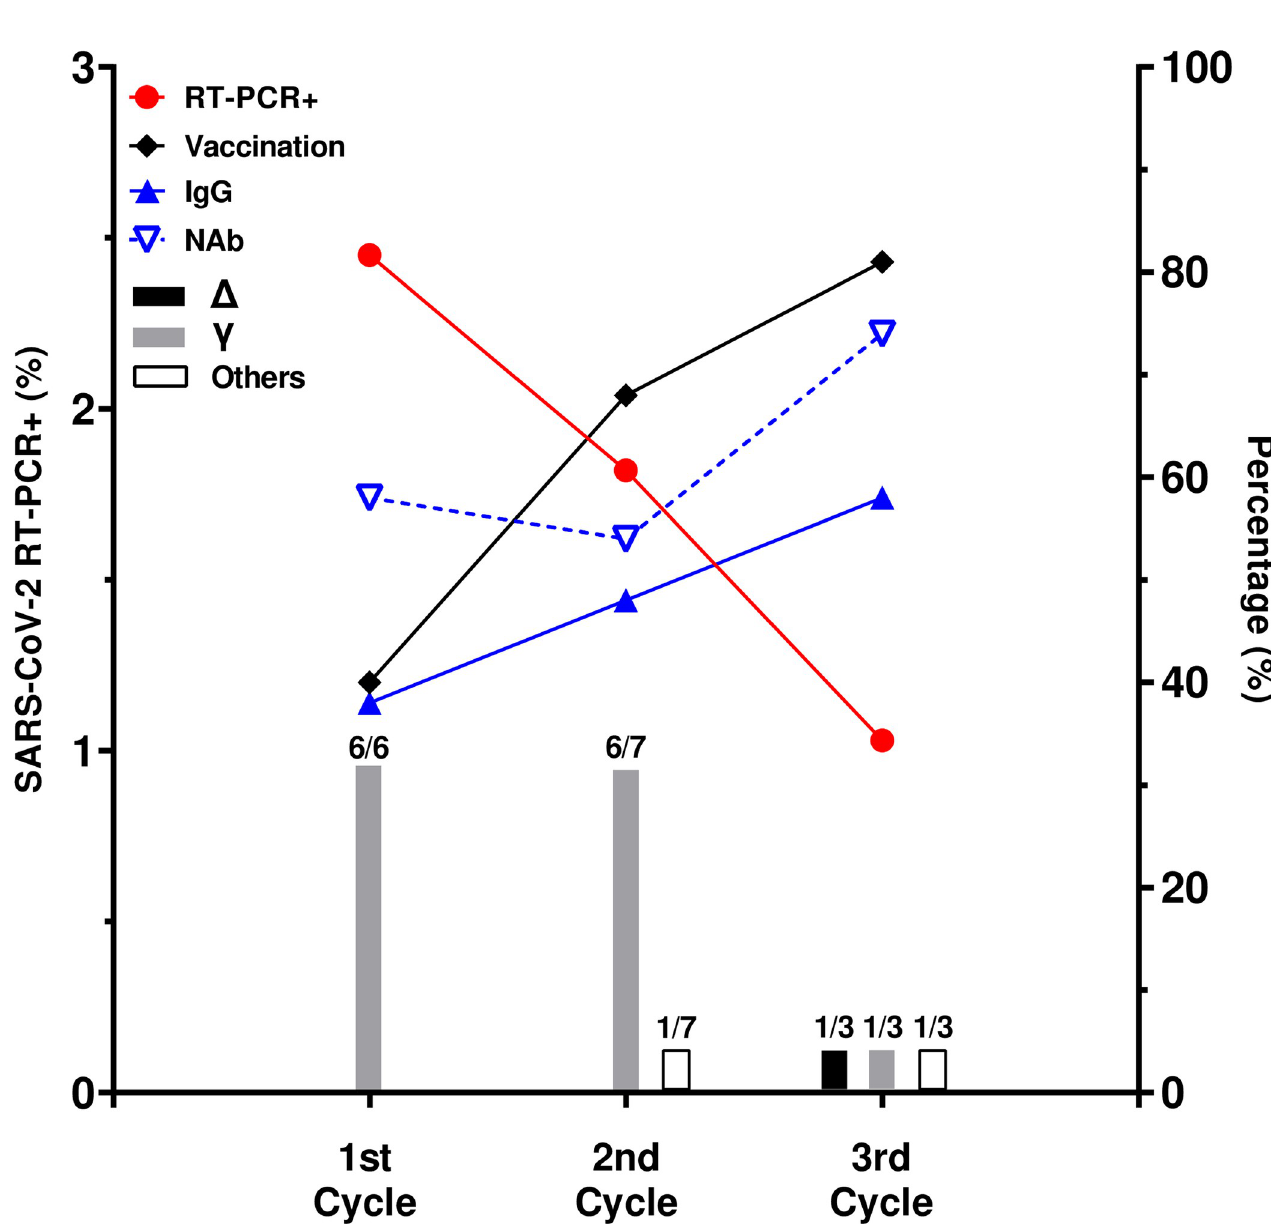
Fig 5. Impact of immunization on COVID-19 incidence on the studied population. On the left Y axis: red line shows de COVID-19 incidence on the studied population over the three round. On the right Y axis: 1) black line represents the percentage of vaccinated participants through the three rounds; 2) blue line shows the percentage of SCOV2 IgG+ individuals (IgG OD/CO > 1.0); 3) dotted blue line points the percentage of SCOV2 IgG+ individuals carrying detectable levels of NAb. Black, grey, and white bars represent the frequency of Delta ( Δ ), Gamma ( γ ) and other VOCs, respectively, in the city of Marica´ when all three rounds were